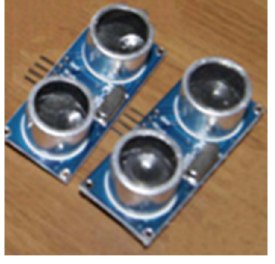
Figure 4. Ultrasonic transducers.